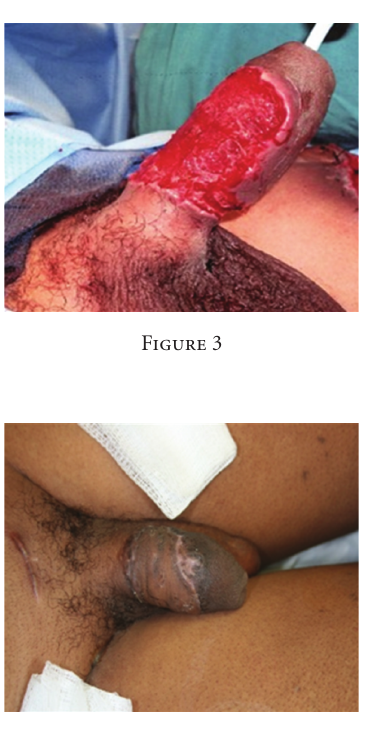
Figure 4: (FTSG 7 days